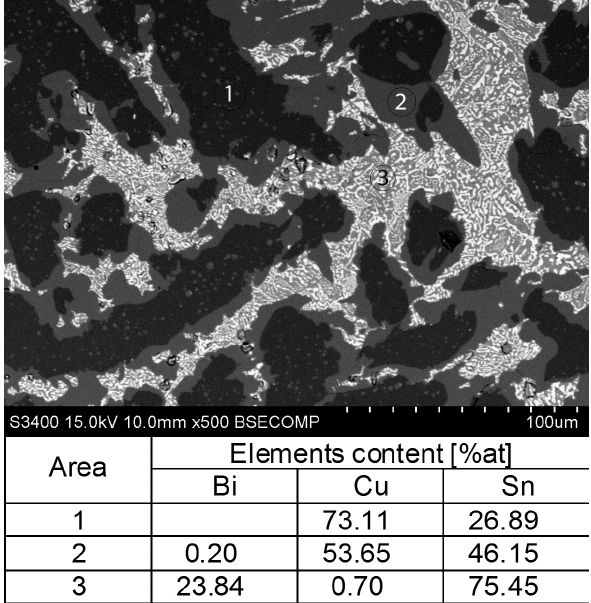
Figure 12: Microstructure of the alloy no 6.